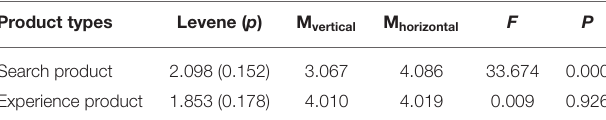
TABLE 3 | Test of product type on main